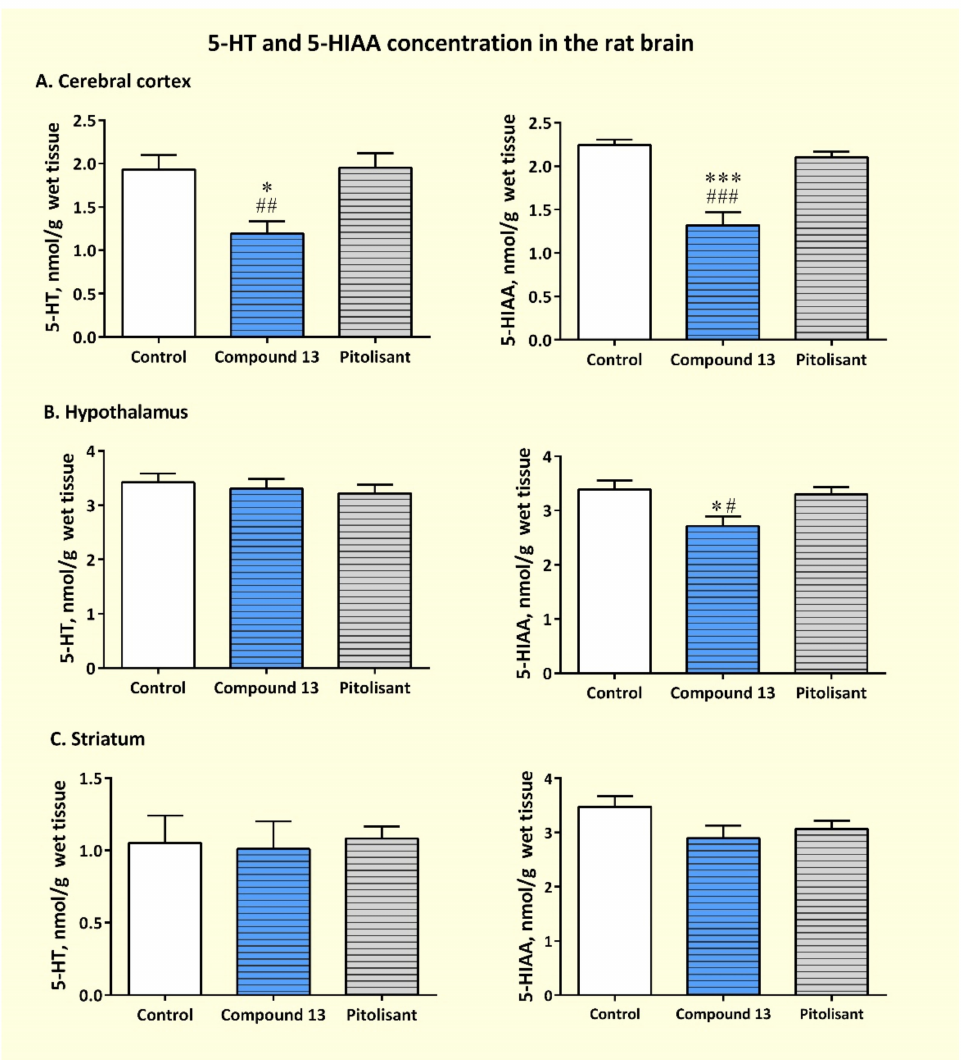
Figure 11. Concentrations of 5-HT and 5-HIAA in brain regions of rats sub-chronically treated with compound 13 and pitolisant (5-HT, serotonin; 5-HIAA, 5-hydroxyindole-3-acetic acid). The tested compounds (both in a dose of 3 mg/kg of body mass) were injected subcutaneously for 6 consecutive days. Values are expressed as nanomoles per gram wet weight and are means ± SEM (n = 7–8). One-way ANOVA and Tukey’s multiple comparisons test: * vs. control, # vs. pitolisant. One symbol means p < 0.05, two symbols p < 0.01, while three symbols p <